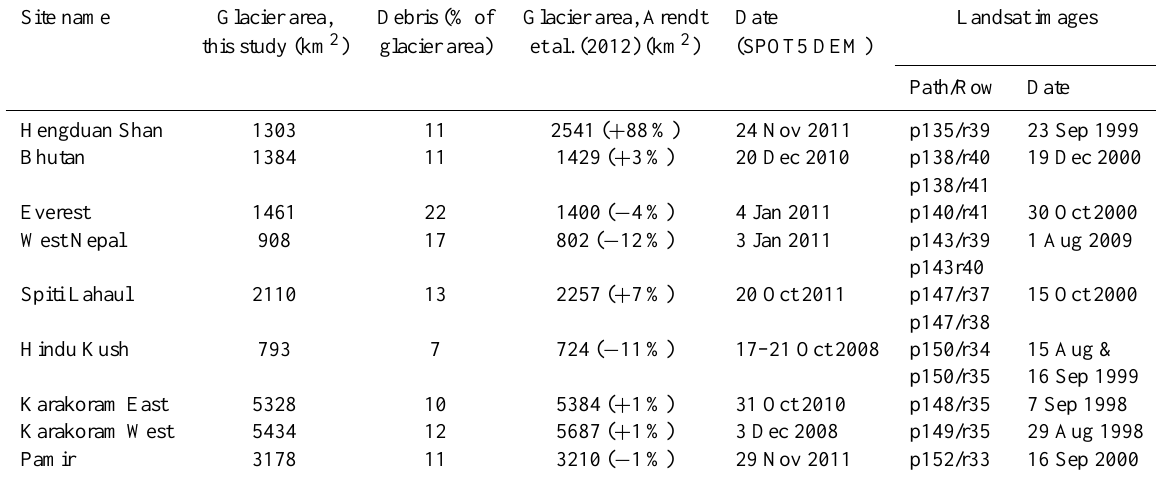
Table 1. Characteristics of the nine study sites. Numbers between parentheses indicate the percentage difference between our user-defined glacier inventory and the RGI v2.0. (Arendt et al., 2012). Site name Glacier